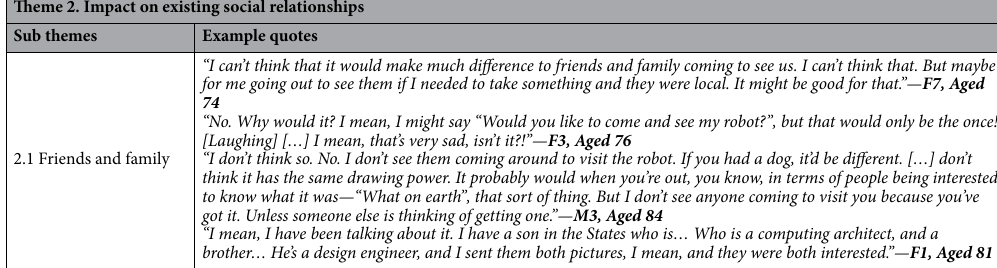
Table 3. Impact on existing social